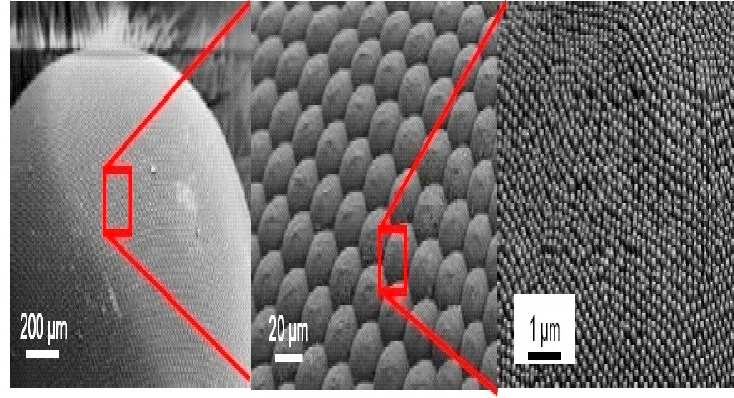
Figure 2. The structure of moth ‐ eyes which is covered by the nano ‐ structured film [8,17].